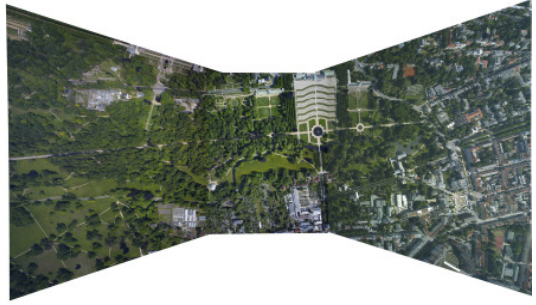
Figure 1: Stitched image triple